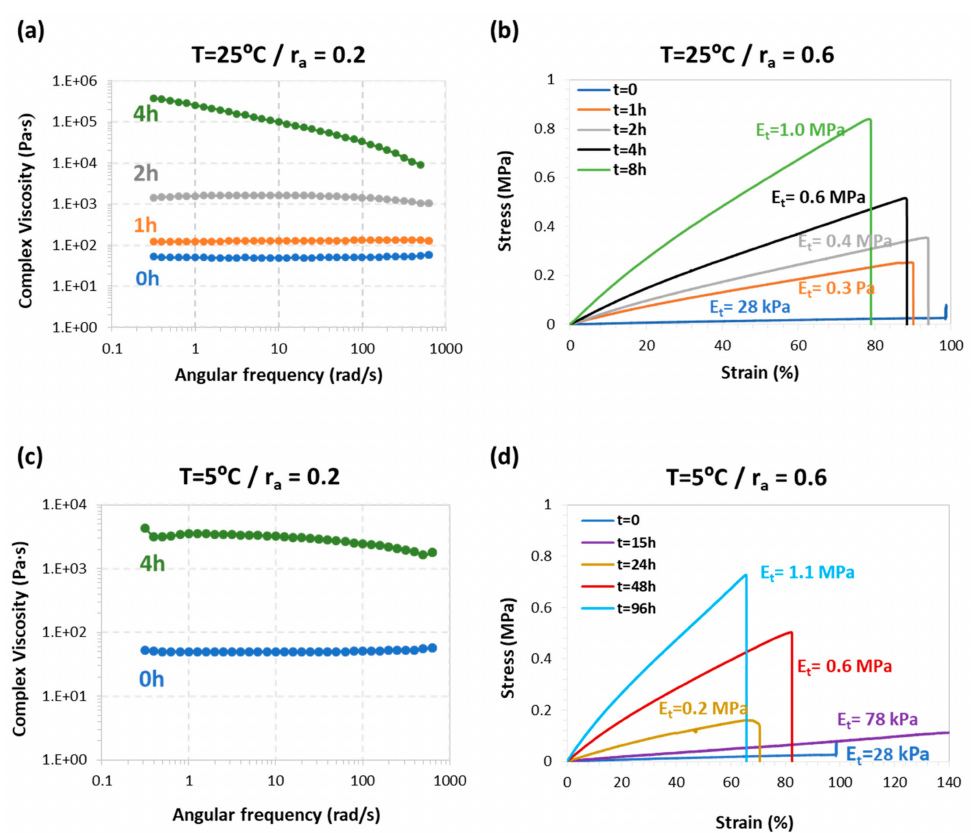
Figure 7. Results of the mechanical evaluation of the second reaction latency: ( a ) changes in complex viscosity of TCDDA02 during 25 ◦ C storage; ( b ) evolution of the tensile modulus of TCDDA06 intermediate at 25 ◦ C storage temperature; ( c ) changes in complex viscosity of TCDDA02 during 5 ◦ C storage and ( d ) evolution of the tensile modulus of TCDDA06 intermediate at 5 ◦ C storage